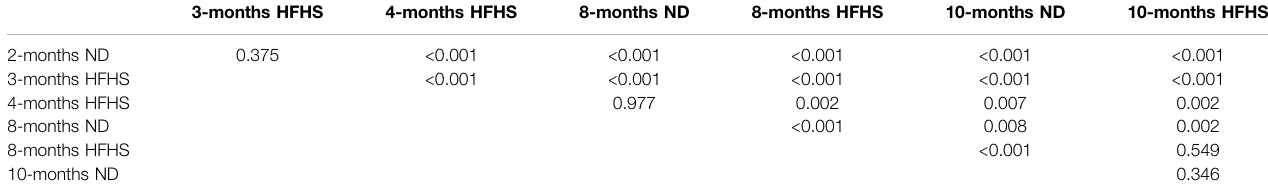
TABLE 1 | The p -values were obtained from Friedman test and Skillings-Mack test between grops. 2-months ND ( n = 6), 3-months HFHS ( n = 6), all other groups ( n = 5). Tests were performed on average HD values with SBP bins ranging from 110 – 140 mmHg between each age/diet group.